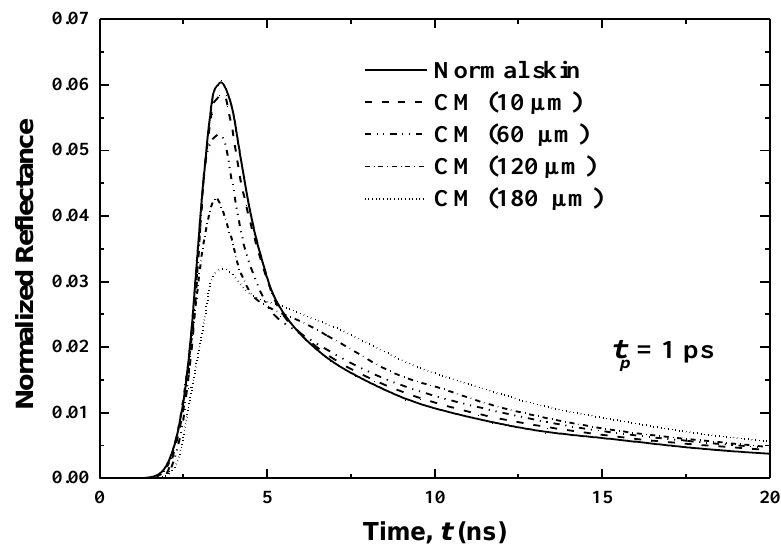
Figure 10. Effects of affected volumes on the temporal reflectance signals from the skin with CM malignancy.